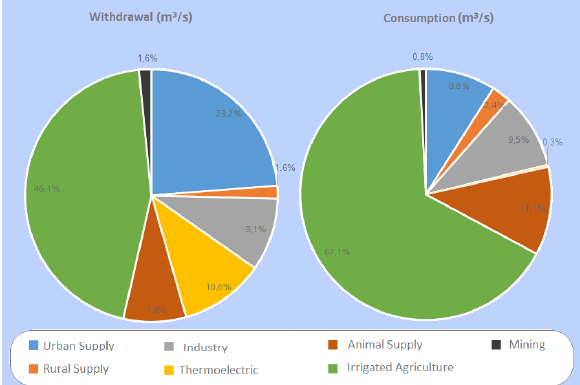
Figure 1. Water use in Brazil by sectors. Source: Adapted from ANA (2017)